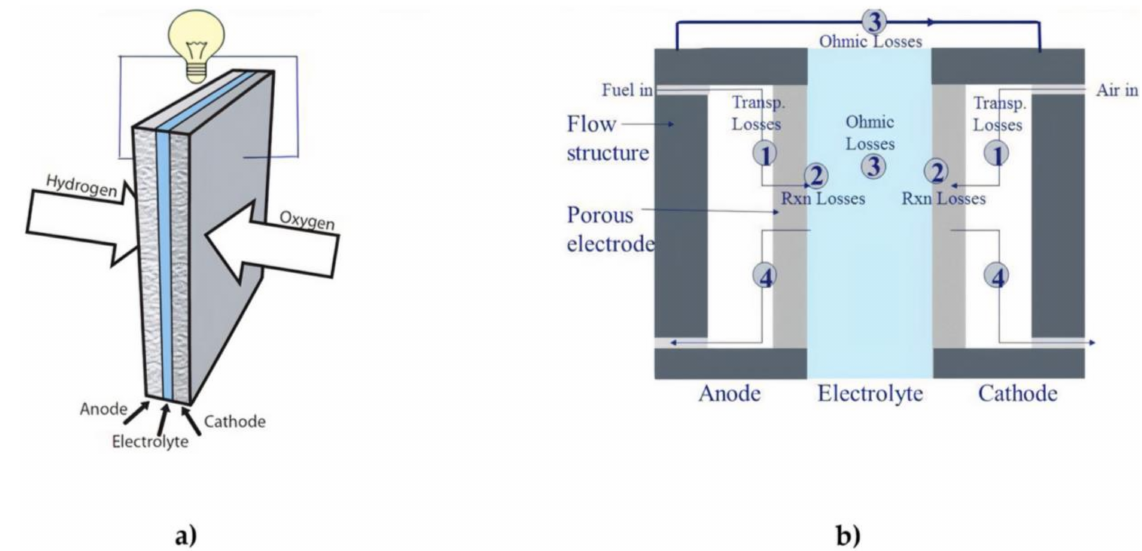
Figure 1. Oprational characteristics of Hydrogen fuel cells [39]. ( a ) Packed view of Fuel Cell; ( b ) Exploded view of Fuel